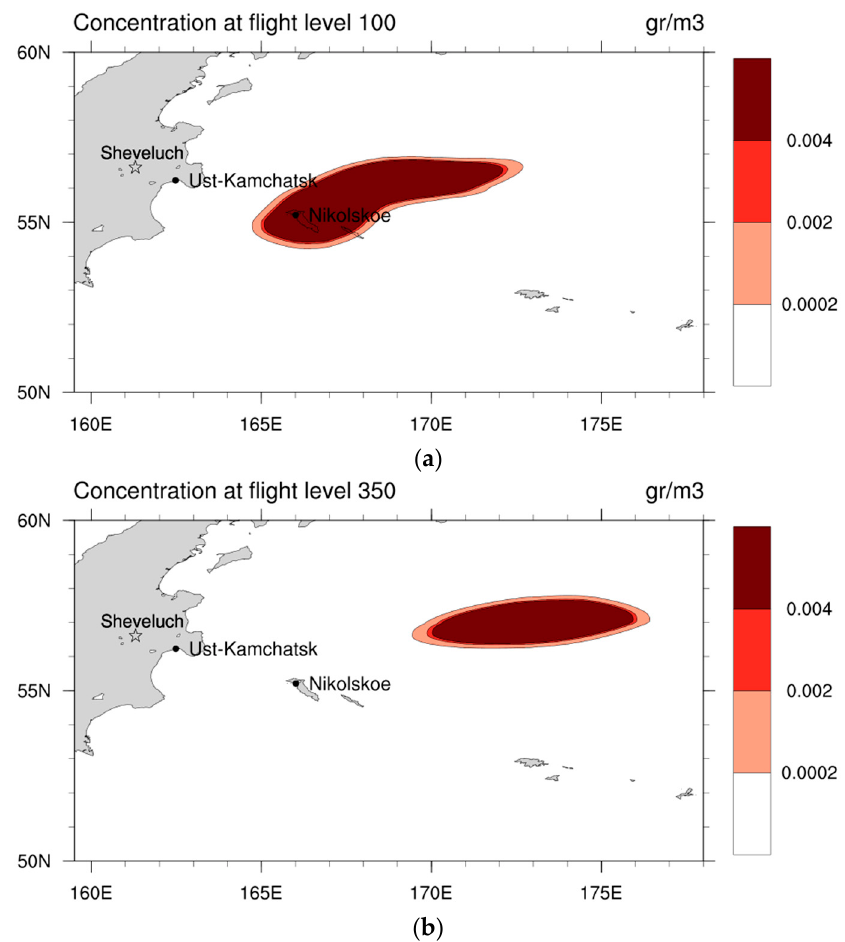
Figure 15. Visualization of the Sheveluch volcano eruptive clouds hazardous to aviation on the flight levels 100 ( a ) and 350 ( b ) as of 04:22 UTC, 12 November 1964.